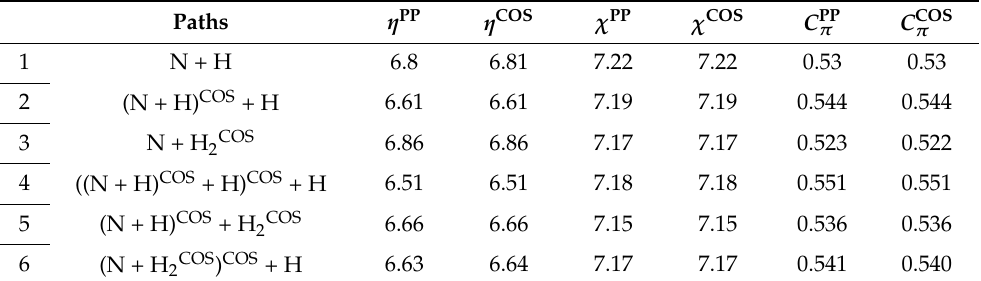
Table 6. The essential information as in Table 5, here for the target NH 3 molecule.